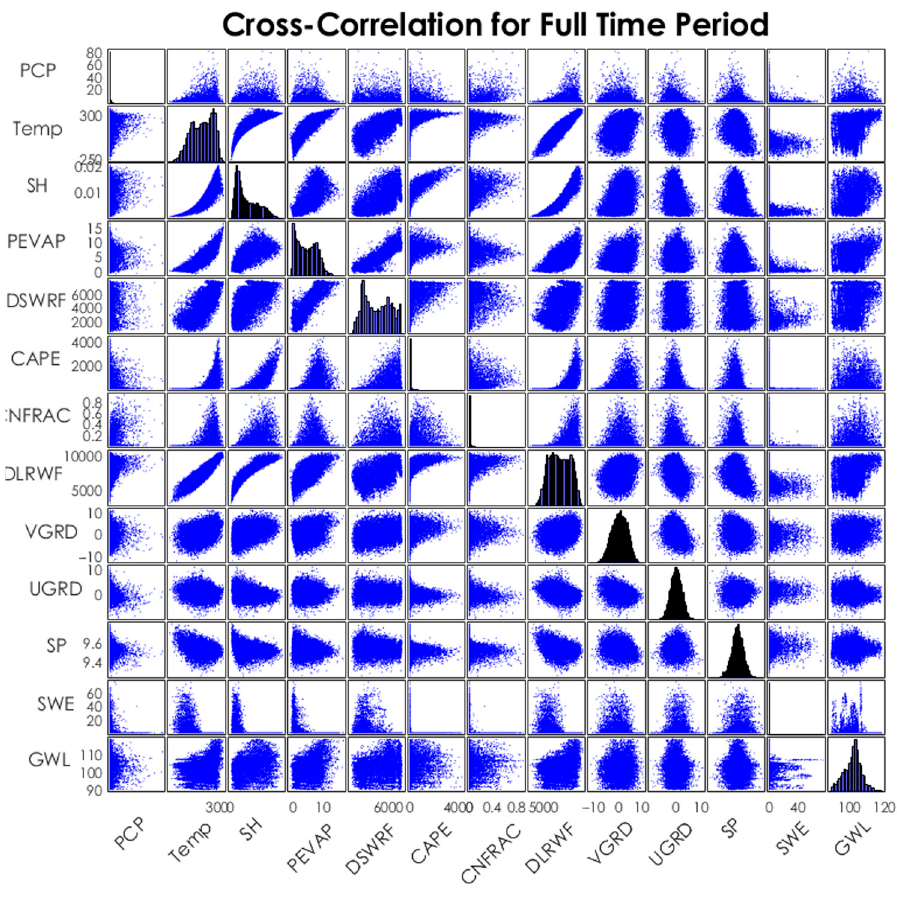
Figure 3. Cross ‐ correlation pair plot for all 13 predictive variables over the full time period.